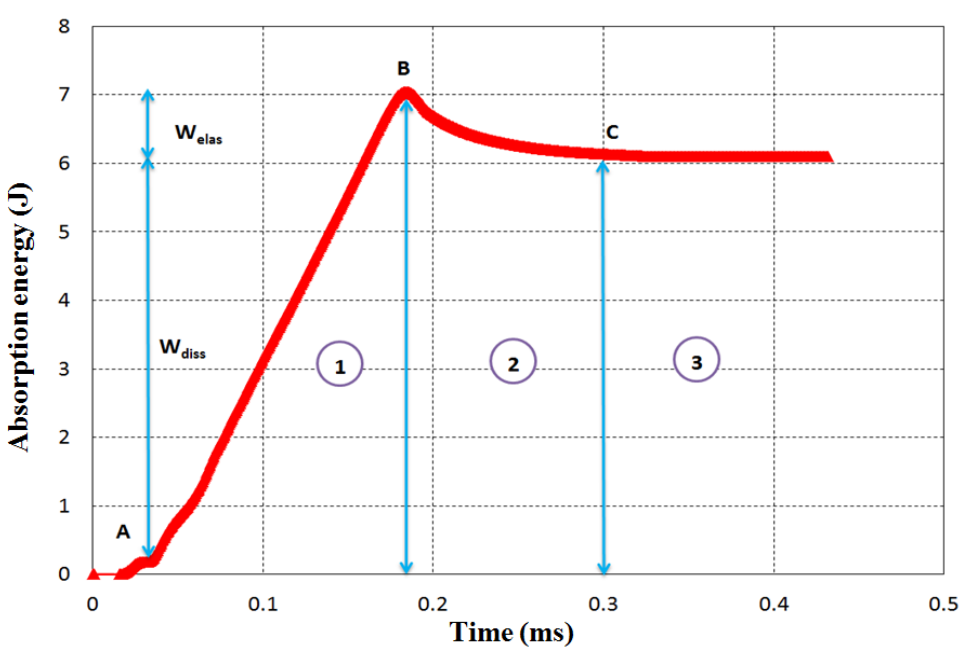
. Figure 10. Typical profile of absorbed energy W abs (cid:3028)(cid:3029)(cid:3046)